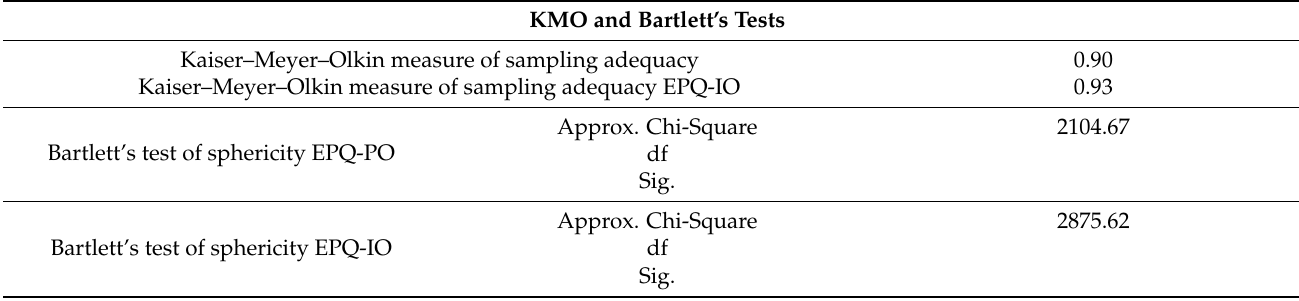
Table 4. Kaiser–Meyer–Olkin (KMO) sample adequacy test.